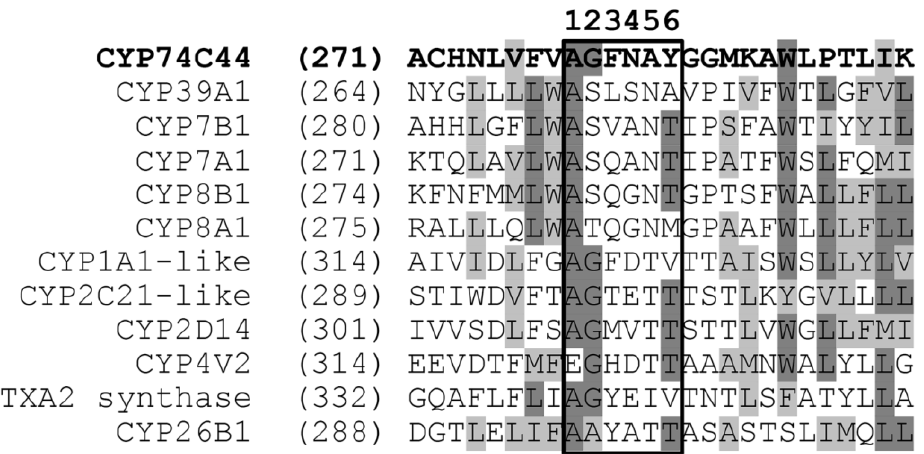
Figure 3. Partial multiple alignment of CYP74C44 vs. the selected P450s of S. hondurensis (I-helix